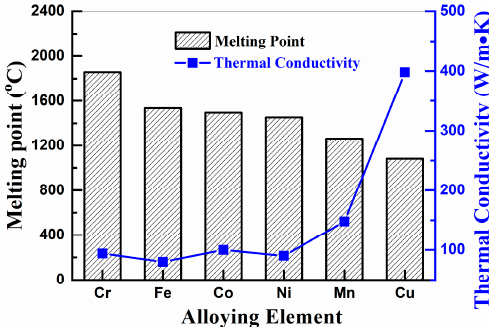
Figure 9. Melting point and thermal conductivity of elements in CoCrCuFeMnNi HEA system